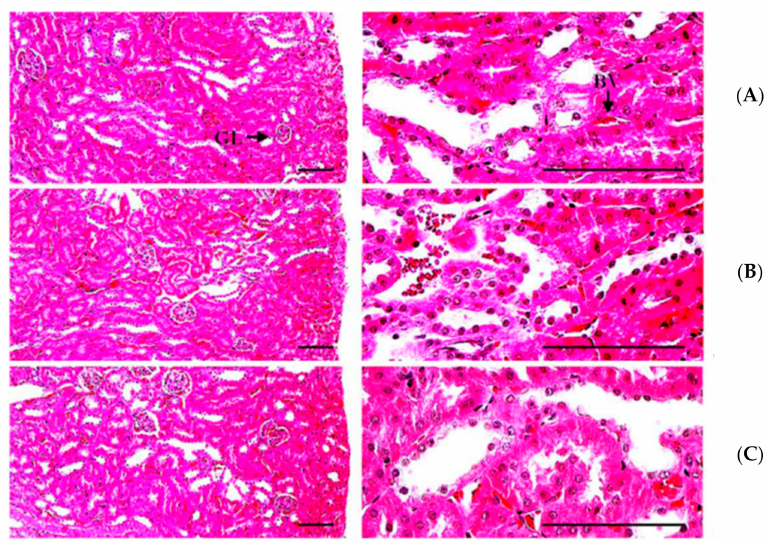
Figure A3. Representative histopathological profiles of kidney tissues: ( A ) normal diet control ( n = 7); ( B ) voglibose ( n = 7); ( C ) enzyme mixture ( n = 7). GL, glomerulus; BV, blood vessel. Scale bars: 100 µ